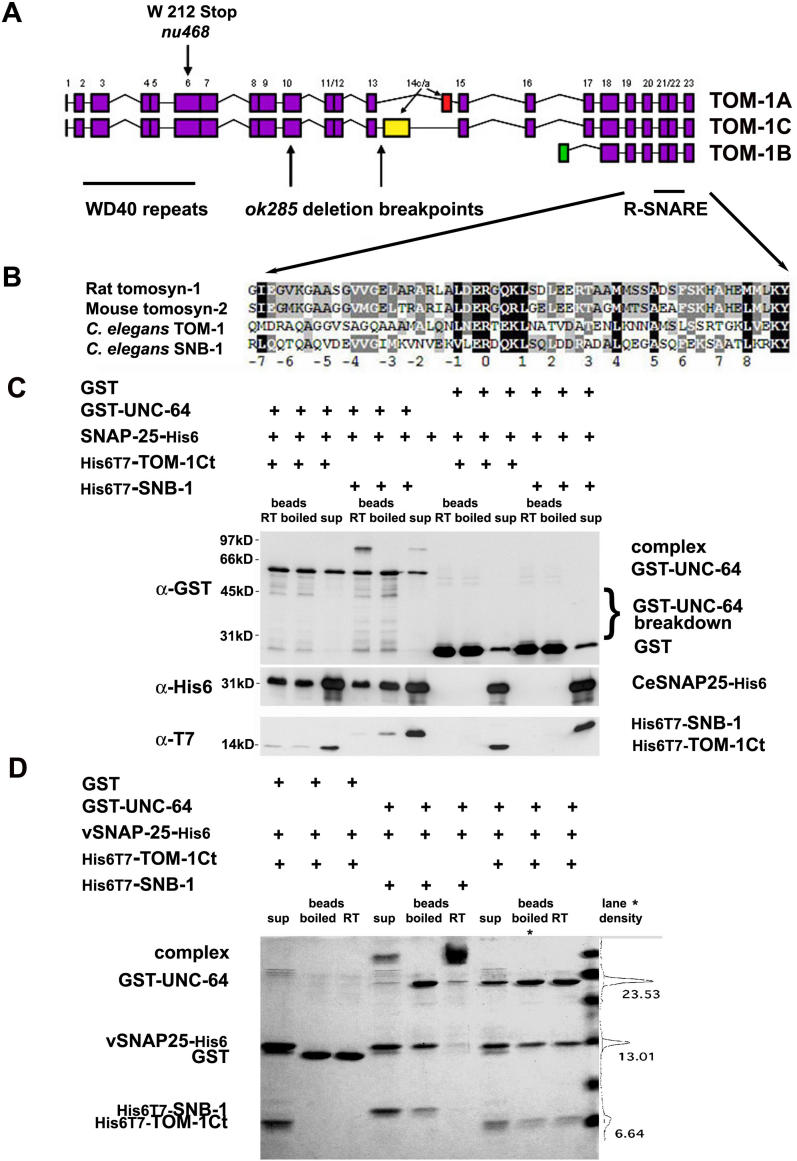
TOM-1 Is the
C. elegans Tomosyn Homolog
(A) Gene structure of the three
C. elegans TOM-1 isoforms. All isoforms were confirmed by expressed sequence tags 3′ to the 6th exon and the upstream 5′ region common to TOM-1A, and TOM-1C was determined by 5′ RACE. The two long isoforms TOM-1A and TOM-1C contain N-terminal WD40 repeats and a C-terminal SNARE domain. The short isoform (TOM-1B) contains only the SNARE domain.
tom-1(nu468) is a G to A change in W212 resulting in an early stop predicted to disrupt isoforms TOM-1A and TOM-1C [
16]. The mutation in
tom-1(ok285) is a 1,580-bp deletion that removes part of exon 10 and all of exons 11 through 13.
tom-1(ok285) disrupts TOM-1A but, by RT-PCR can produce a mRNA capable of encoding an alternative isoform of TOM-1C lacking exons 11–13 and containing a partial exon 10 and an extra eight amino acids.
(B) Amino acid alignment of the R-SNARE domain of rat tomosyn-1, mouse tomosyn-2,
C. elegans TOM-1, and
C. elegans synaptobrevin-1. Identity is shown as black boxes and similarity as gray boxes. Numbers below indicate helical layers formed during SNARE complex assembly.
(C) TOM-1Ct forms tomosyn SNARE complexes with syntaxin and SNAP-25 in vitro to the same extent as
C. elegans synaptobrevin (SNB-1) forms synaptobrevin SNARE complexes.
C. elegans syntaxin::GST, or GST alone was incubated with SNAP-25–His6 and either His6T7-tagged TOM-1Ct, or His6T7-tagged SNB-1. Complexes were isolated using glutathione agarose beads. SDS resistance of complexes was assayed by heating half of the pull-down before electrophoresis. Proteins were separated on SDS-PAGE and transferred to nitrocellulose and detected with anti-GST, anti-His6, and anti-T7 antibodies.
(D) Mixed-species tomosyn SNARE and synaptobrevin SNARE complexes form efficiently. Complexes were formed and isolated as described for (C) except that rat SNAP-25 (vSNAP-25–His6) was used in place of the
C. elegans protein. Complexes were visualized by Coomassie Blue staining after SDS-PAGE. Complex stoichiometry of the tomosyn SNARE complex (*) was estimated by densitometry shown on left. The integrated density of each peak is listed. The molecular weight markers are (from top to bottom) 97 kDa, 66 kDa, 45 kDa, 31 kDa, 21 kDa, and 14 kDa.